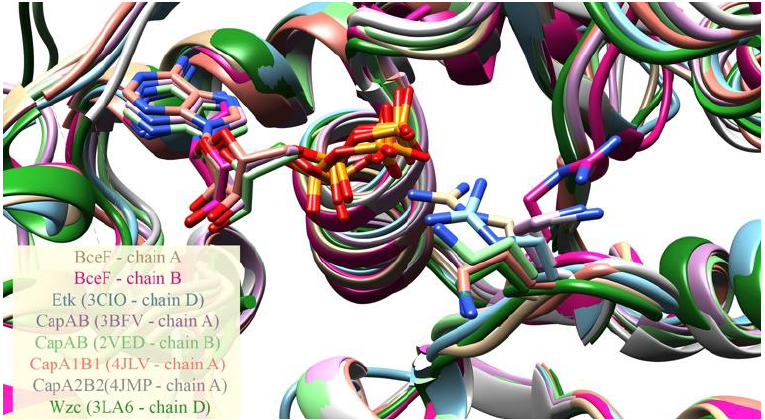
Figure 1. Evolutionary conservation scores projected on the crystal structure of the BceF kinase domain. The crystal structure of the BceF kinase domain (showing one monomer) is colored by evolutionary conservation scores calculated using the ConSurf webserver [21–23]; a variable-to- conserved colored scale is indicated. ADP bound at the active site is represented as space-filled atoms and colored by atom-type with carbons in grey, oxygen in red, nitrogen in blue, and sulfur in yellow. BceF is shown either as ribbons to indicate secondary structures ( A ) or in a solvent-ac- cessible surface representation ( B ). An evolutionary variable helix (residues 500–511, with the ex- ( c ) Number of reflections corresponds to the working set. ( d ) Rwork corresponds to working set. * Calculated ception of the conserved Gln502) and the following evolutionary variable loop (residues 512–518) using Molprobity [26]. close to the active site are indicated with an arrow.